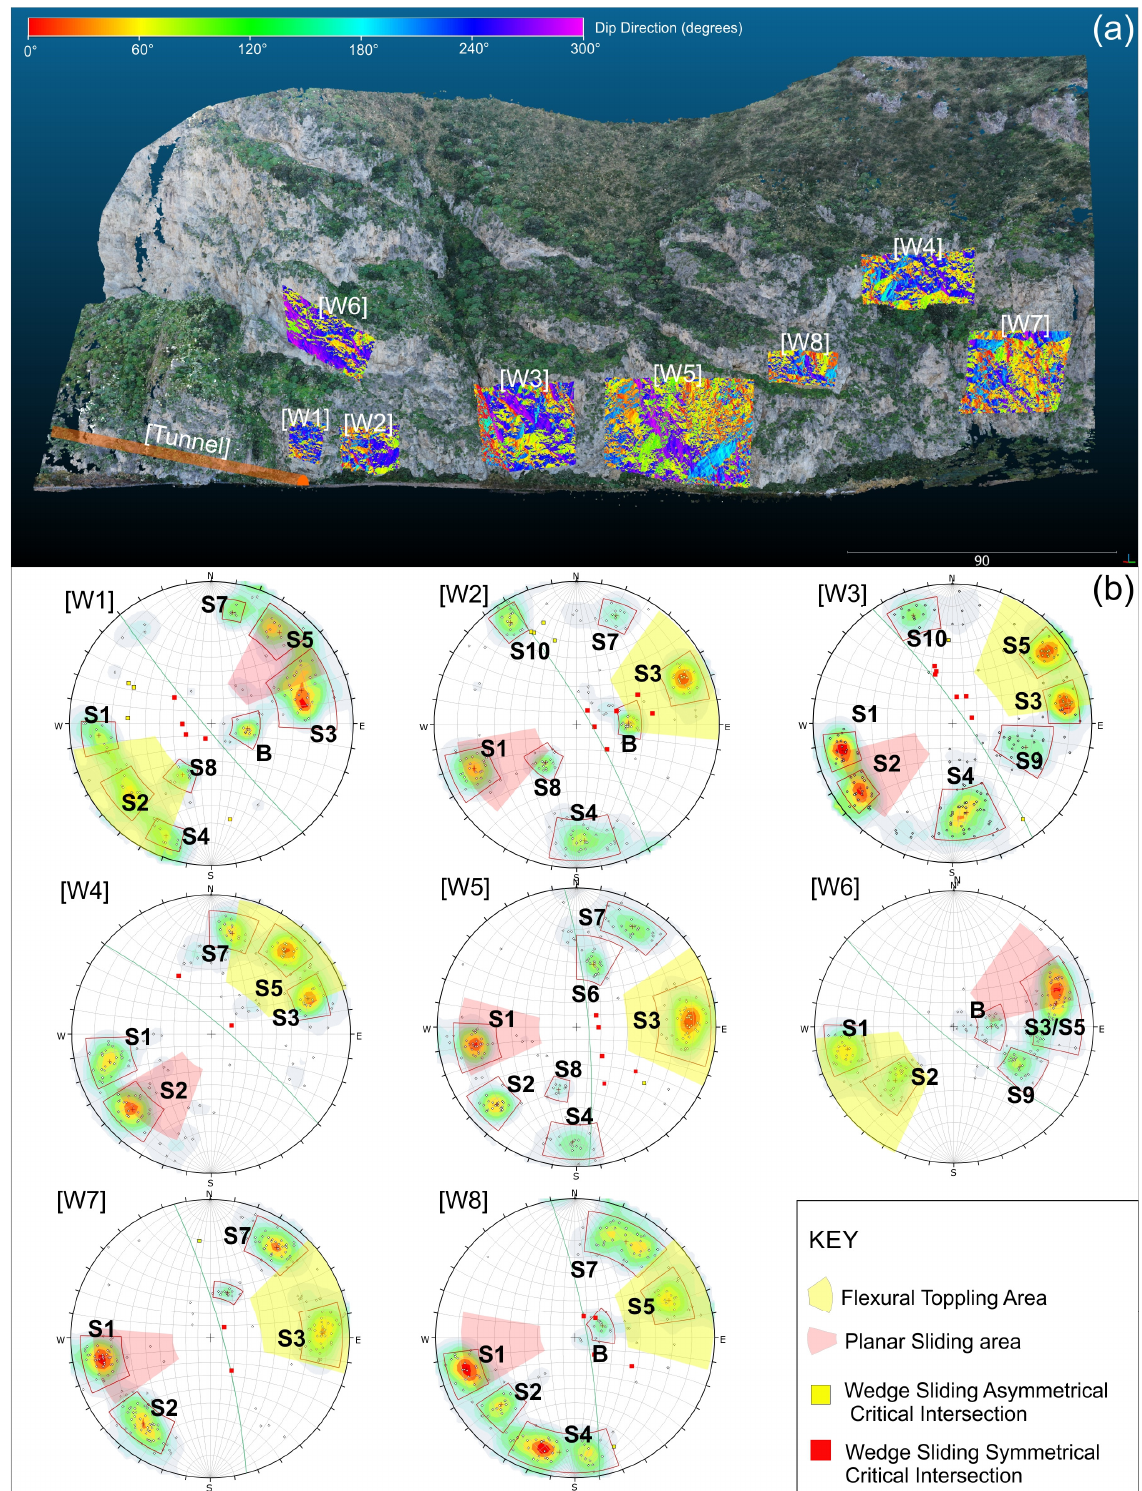
Figure 4. Summary of the UAV photogrammetric survey and resulting data: ( a ) dense point cloud with indication of the surveying windows considered for discontinuity extraction. The chromatic scale at each window refers to the extracted values of dip direction. The orange trace represents the tunnel location within the rock mass; ( b ) geostructural data belonging to each surveying window, with highlighted the main discontinuity sets and related kinematic